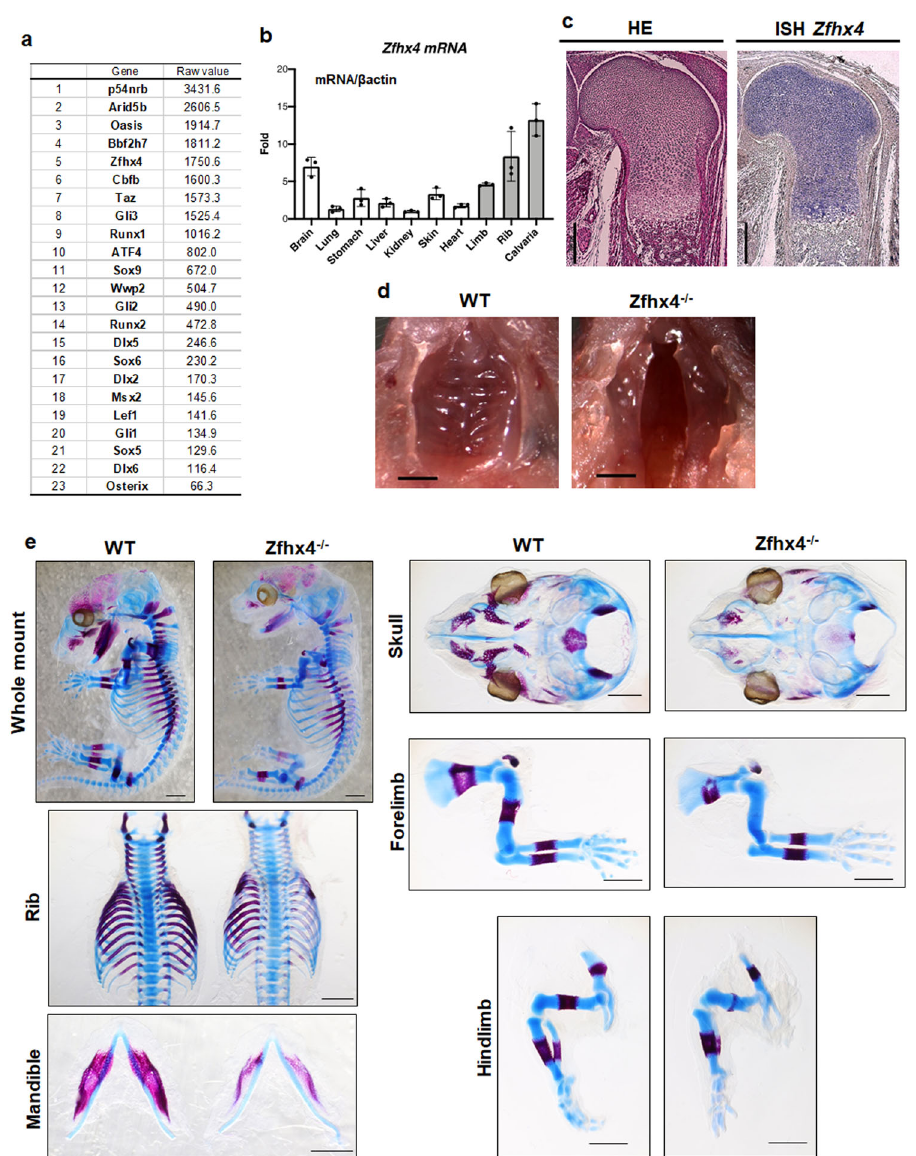
Fig. 1 Identi fi cation of Zfhx4 as an important transcription factor for skeletal development. a List of highly expressed transcription factors in limb buds determined by microarray analysis. b Expression of Zfhx4 in tissues of newborn mice. Total RNA was isolated from the indicated tissues and analyzed by RT-qPCR. Data are shown as the mean ± s.d. ( n = 3). c Expression of Zfhx4 in the growth plate of mice. Hematoxylin and eosin staining (HE) and in situ hybridization ( ISH ) were carried out on growth plate chondrocytes of femurs from E16.5 mice. Scale bar = 500 μ m. d Macroscopic views of the palate of P0 wild-type (WT) and Zfhx4 − / − littermates. Cleft palates were observed in Zfhx4 − / − mice. Scale bar = 1 mm. e Skeletal preparations of whole embryos, ribs, mandibles, skulls, forelimbs, and hindlimbs of E15.5 WT and Zfhx4 − / − littermates stained with Alcian blue and alizarin red. Scale bar = 1 Col10a1 or Mmp13 was detected in Zfhx4 − / − mice (Fig. 2c).